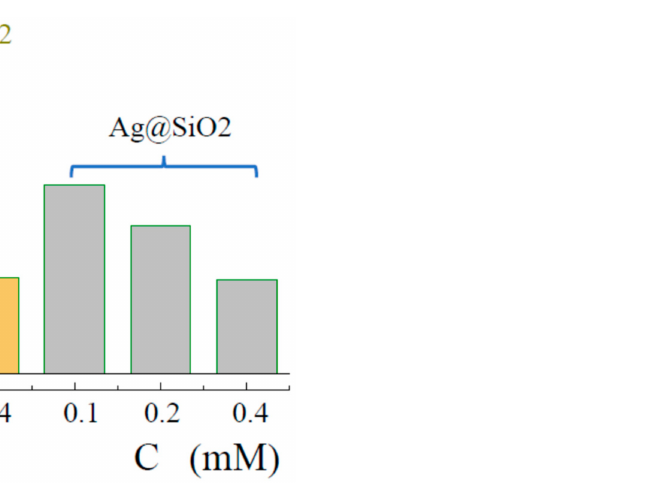
Figure 10. Apparent reduction rate constants of 4-nitrophenol for samples prepared in solutions with different gold and silver salt